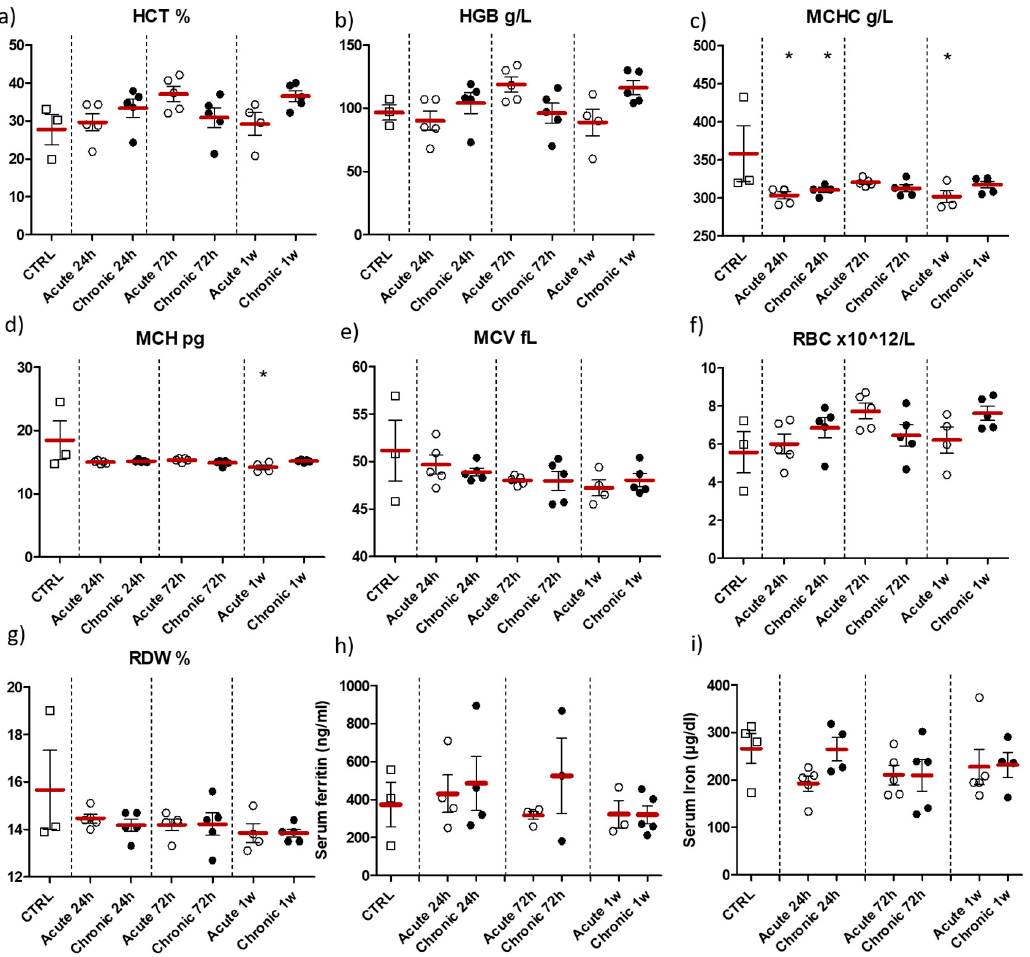
Figure 12. Hematological parameters, serum ferritin and iron levels in the blood samples collected from animals sacrificed following multiple intra-gastric administration of ZnO:Fe 3+,2+ nanoparticles in acute/chronic simulation. Hematocrit—HCT ( a ), hemoglobin concentration—HGB ( b ), mean corpuscular hemoglobin concentration—MCHC ( c ), mean corpuscular hemoglobin—MCH ( d ), mean corpuscular volume—MCV ( e ), erythrocyte count—RBC ( f ), red cell distribution width—